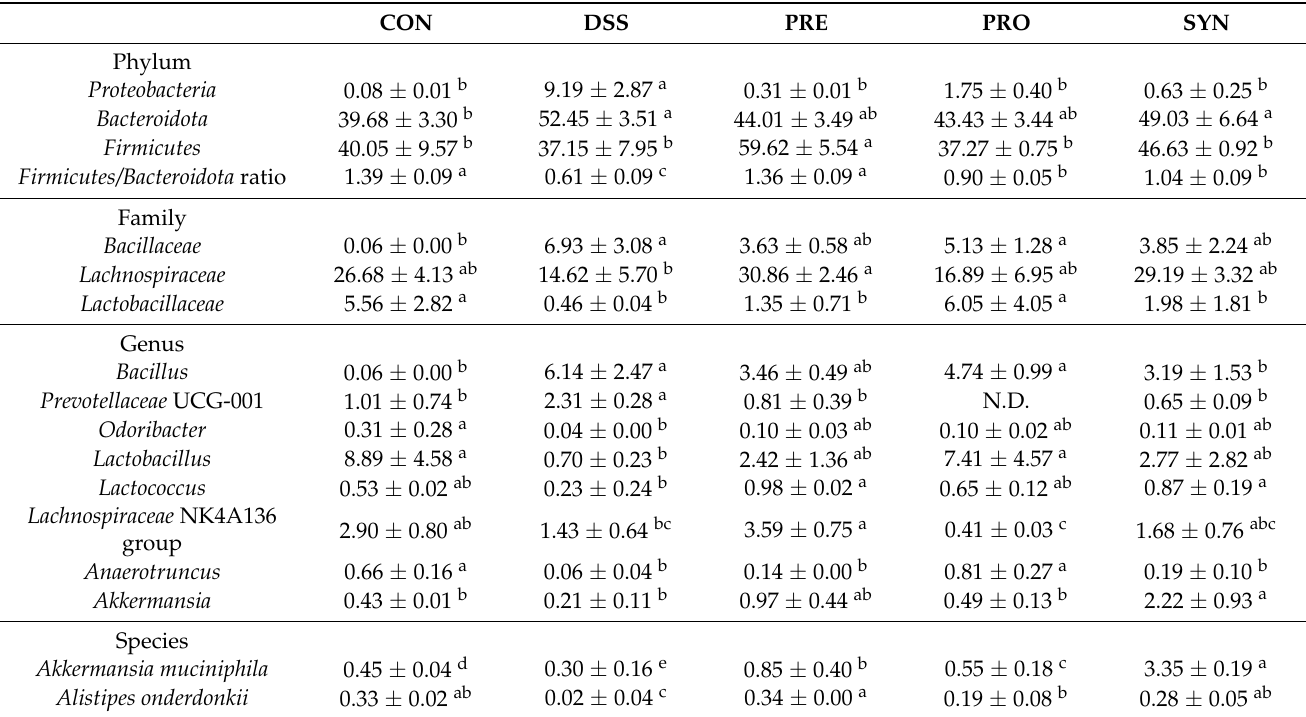
Table 1. Effect of PRE, PRO, and SYN on gut microbiome composition relative abundance of DSS- induced colitis mice.